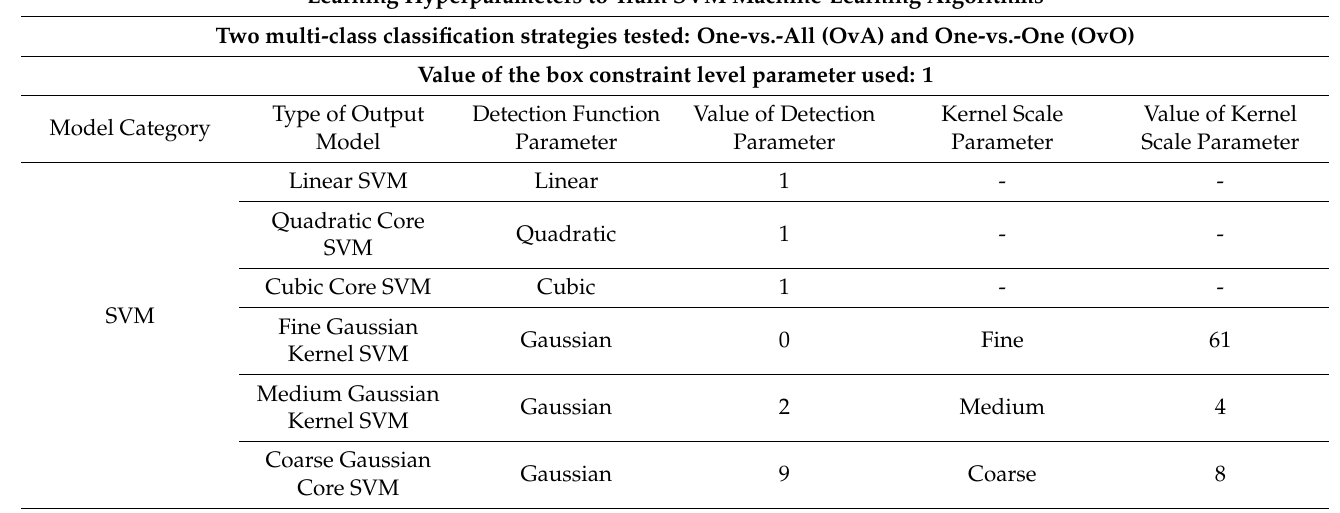
Table 3. Learning hyperparameters and methods used to train SVM, KNN and RF machine-learning